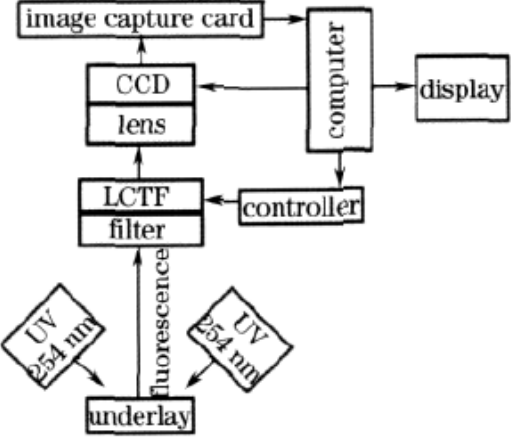
Fig. 1. Spectral imaging system